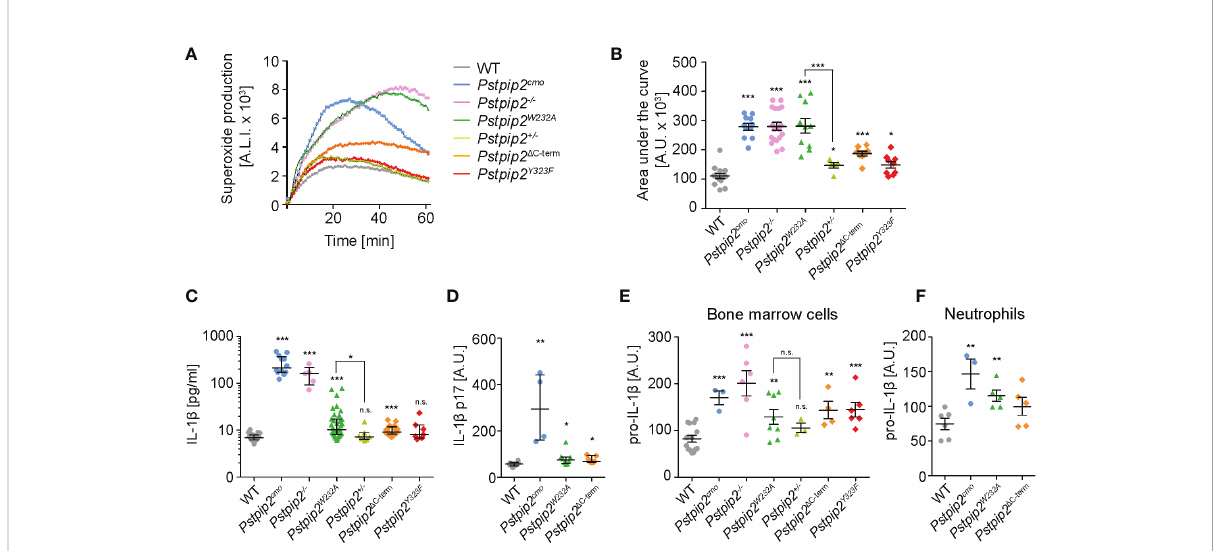
FIGURE 3 Production of superoxide and pro-IL-1 b by neutrophils from WT and mutant mouse strains. (A) Superoxide production by silica-stimulated bone marrow cells measured in 1-min intervals by luminol-based chemiluminescence assay. (B) Quanti fi cation of the area under the curve for superoxide production measurements performed as in (A) on bone marrow cells from multiple mice. (C) IL-1 b concentration in hind paw lysates detected by ELISA. (D) Quanti fi cation of active IL-1 b p17 in hind paw lysates detected by Western blot. (E, F) Pro-IL-1 b production by bone marrow cells (E) or puri fi ed neutrophils (F) activated with 10 ng/ml LPS detected by immunoblotting. Error bars represent mean ± SEM in (B, E, F) and median with interquartile range in (C, D) . Asterisks above individual columns describe p values for comparisons with WT, asterisks above connecting lines describe p values for comparisons of the columns connected by these lines; *p ≤ 0.05, **p ≤ 0.01, ***p ≤ 0.001, n.s. not signi fi cant. See Materials and Methods for further details on statistical